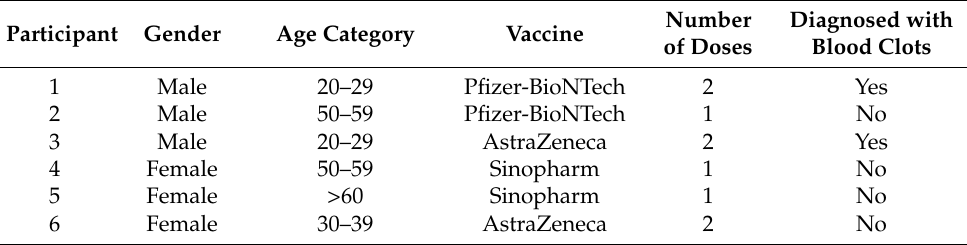
Table 10. Data of participants who were diagnosed with